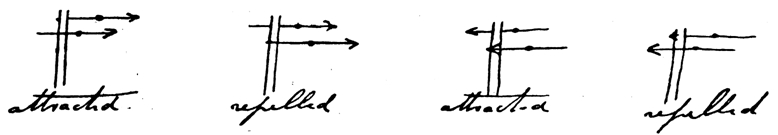
 The wire is construed as having four positions per magnetic pole.